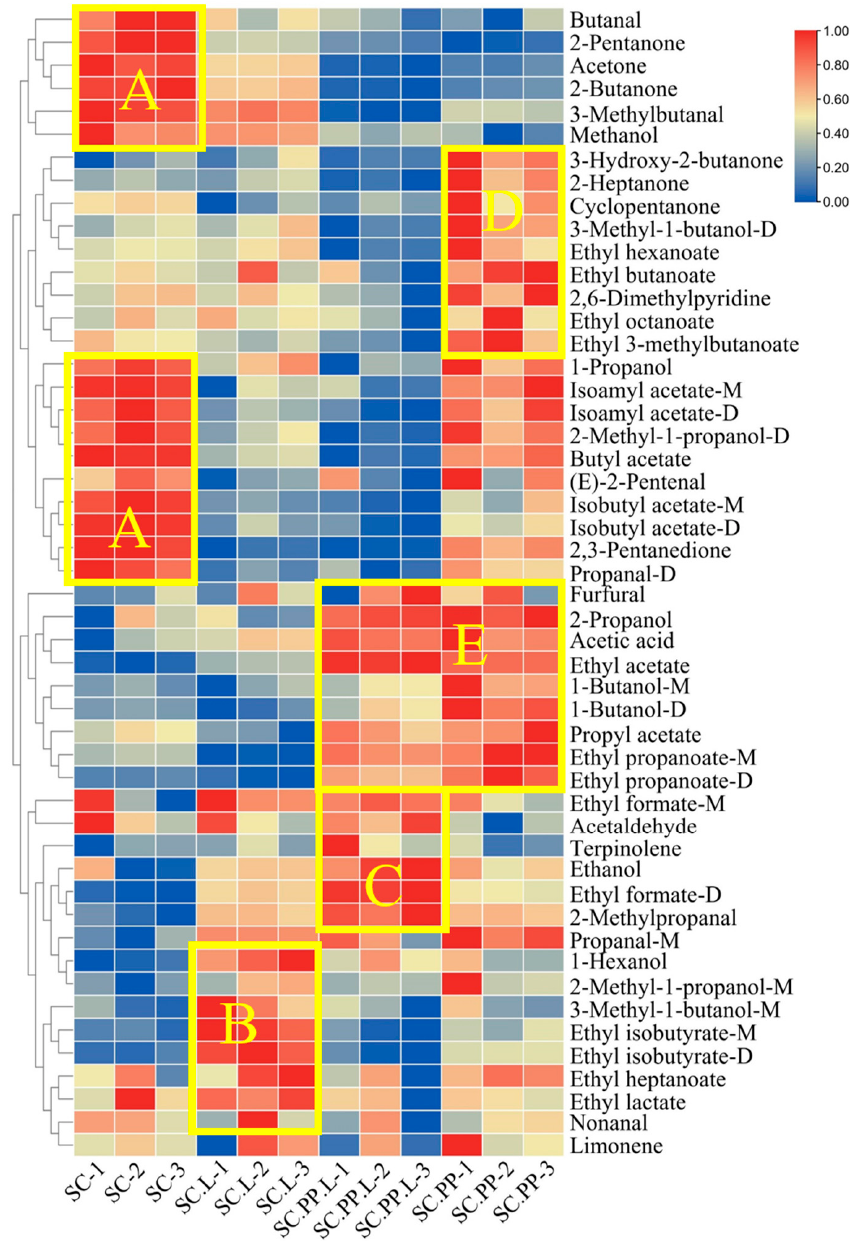
Figure 2. GC-IMS Two-Dimensional Spectra. ( a ) Intuitive comparison Spectra; ( b ) difference com- parison Spectra. ( S. cerevisiae -‘SC’, S. cerevisiae and Lactobacillus -‘SC.L’, S. cerevisiae , and P. pastoris -